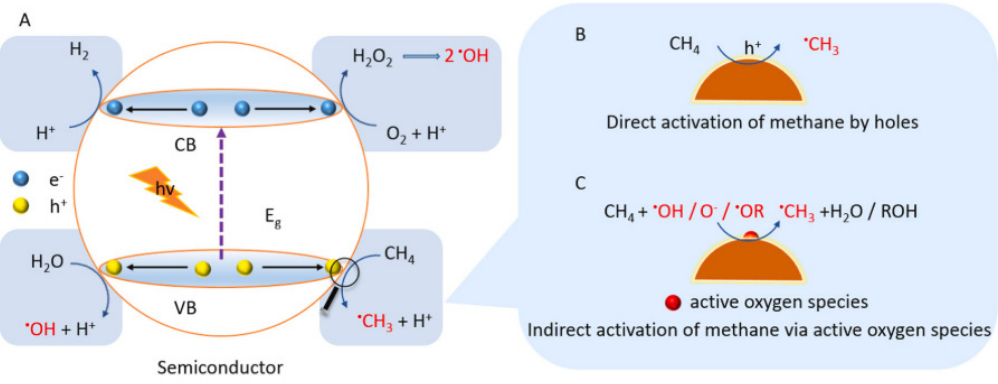
Figure 7. Schematic mechanism of methane activation by semiconductor [18]. Reproduced with permission from Lin et al. Copyright © 2022 Elsevier.